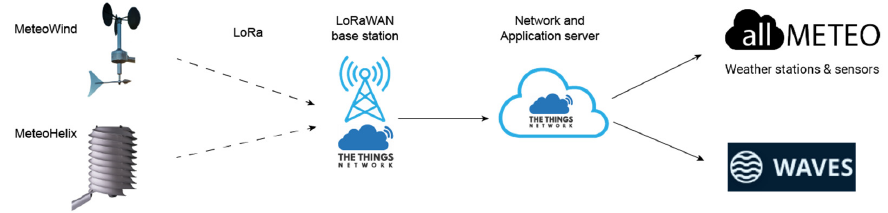
Figure 6. Architecture of LoRaWAN-enabled MeteoHelix and MeteoWind devices from Barani Design.